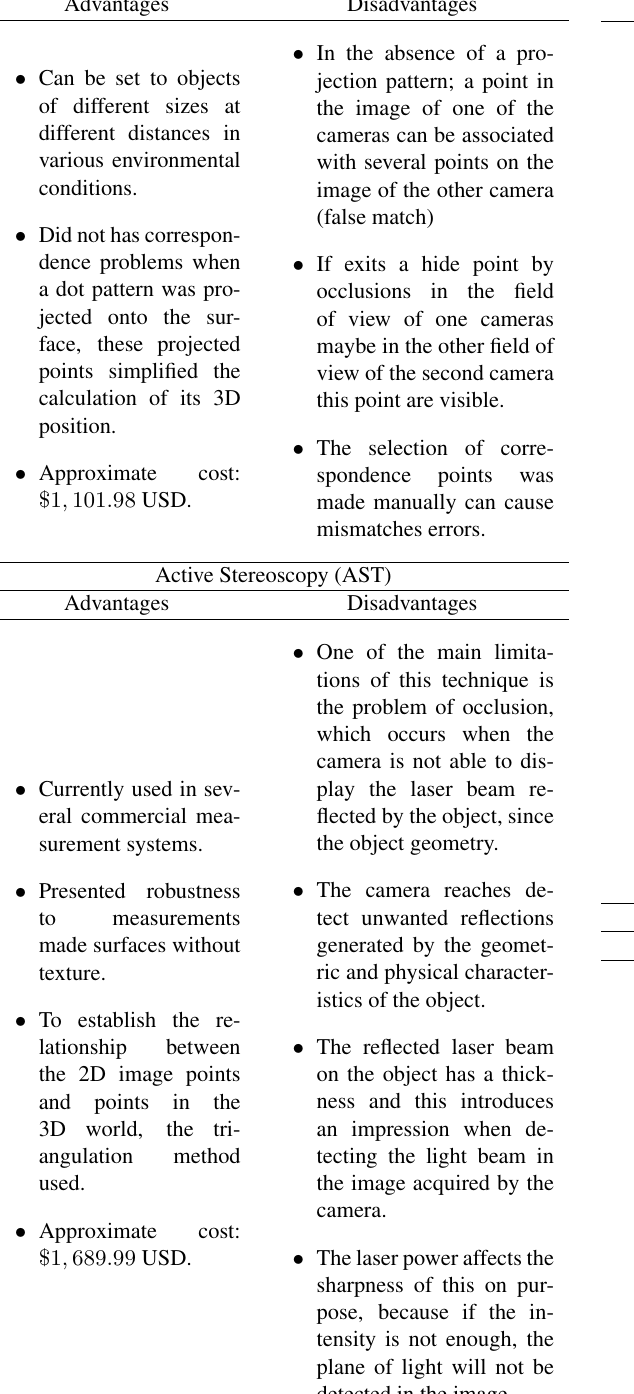
Shape from contour